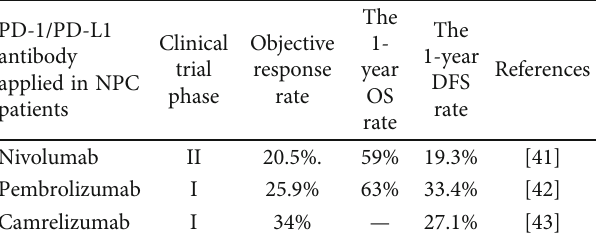
Table 2: Summary of PD-1/PD-L1 antibodies in several clinical